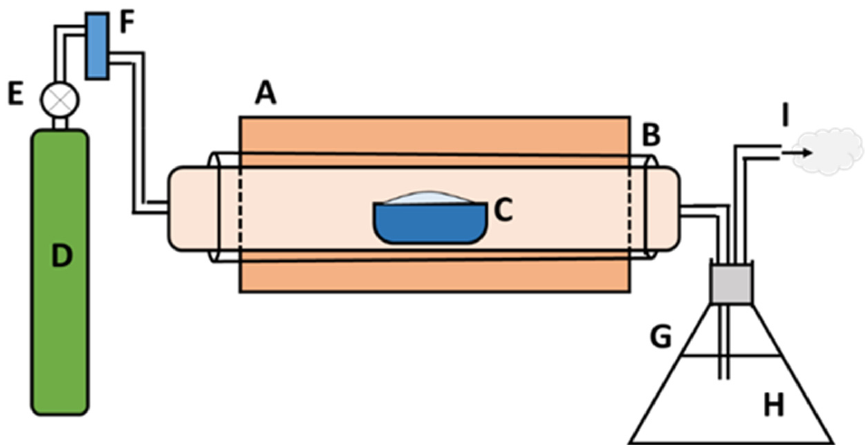
Figure 1. The schematic illustration of pyrolysis system setup: ( A ) electrical furnace, ( B ) ceramic tube, ( C ) alumina boat, ( D ) N 2 gas cylinder, ( E ) gas regulator valve, ( F ) flow rate meter, ( G ) conical flask, ( H ) water, and ( I ) outlet gas.